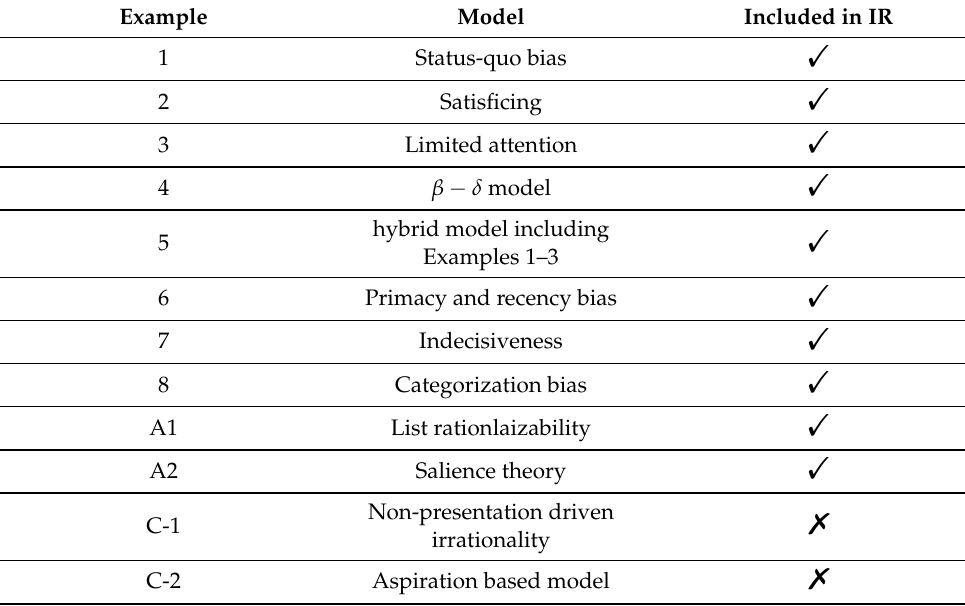
Table 1. List of behavioral